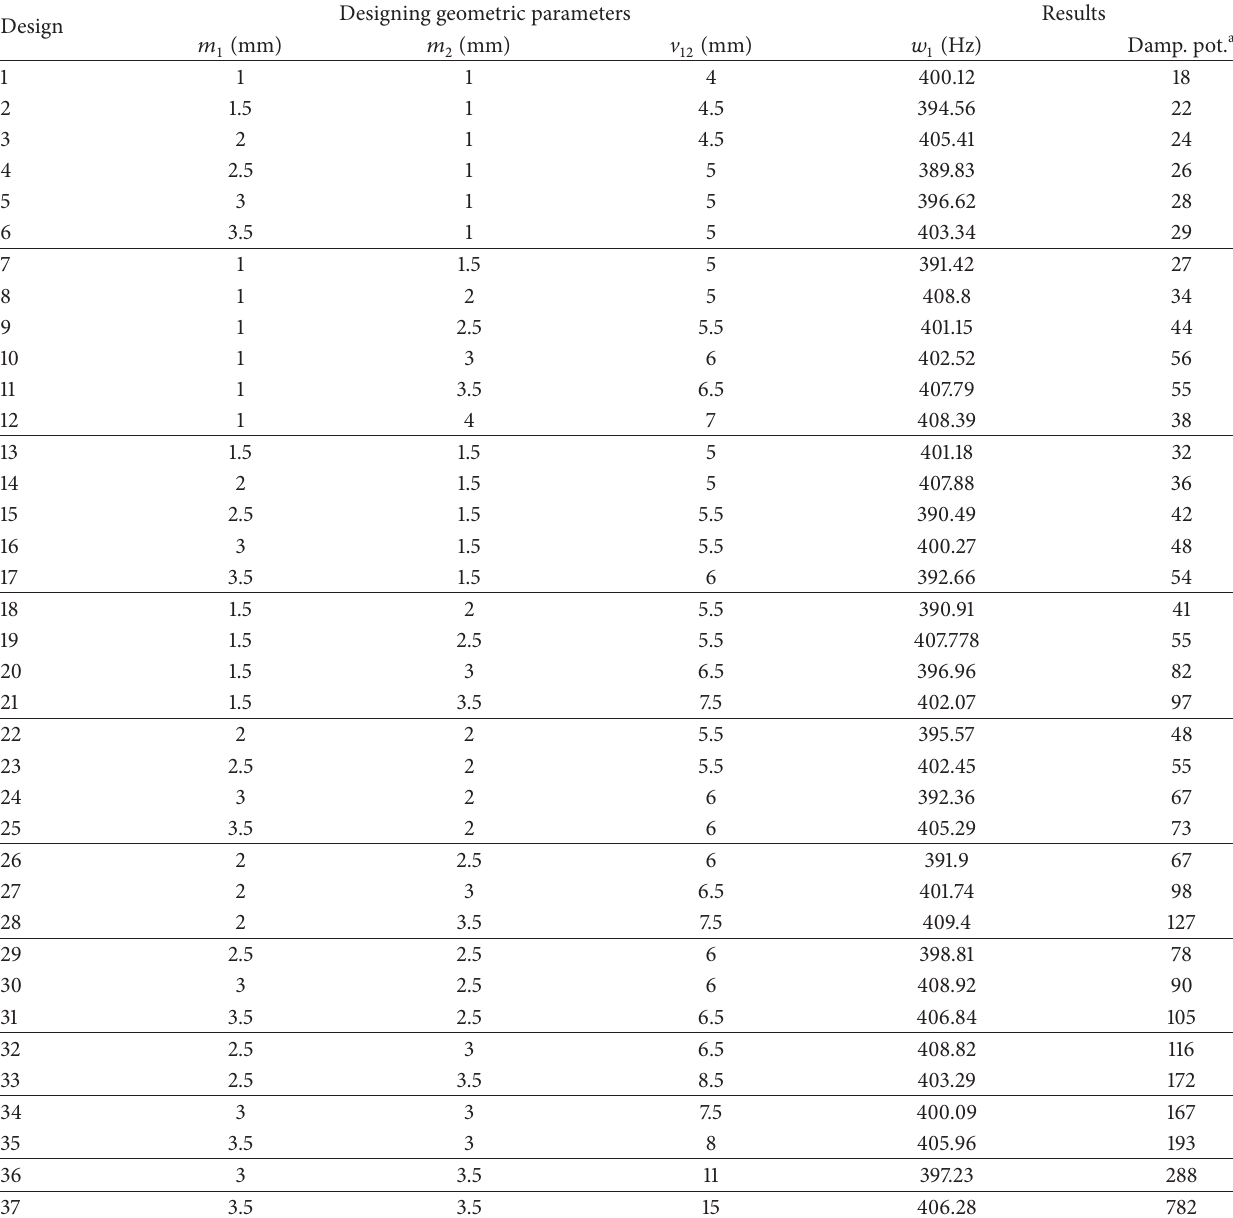
a Damp. pot. refers to the peak amplitude of the damping potential